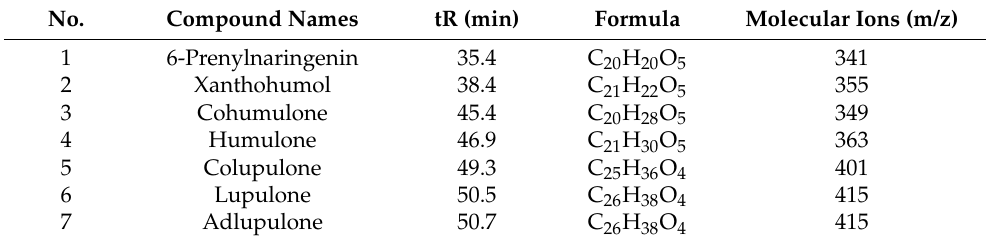
Table 1. Identification of prenylflavonoid compounds by LC-MS.